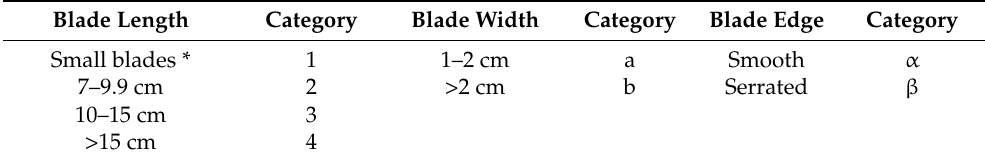
Table 2. Tool blade categories used in this study. Blade Length Category Blade Width Category Blade Edge Category Small blades *